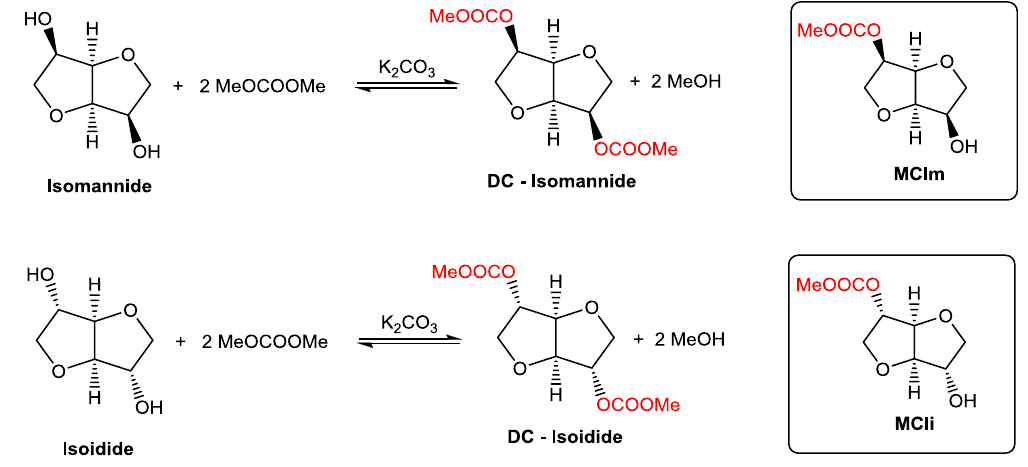
Scheme 3. Carboxymethylation of isomannide and isoidide.